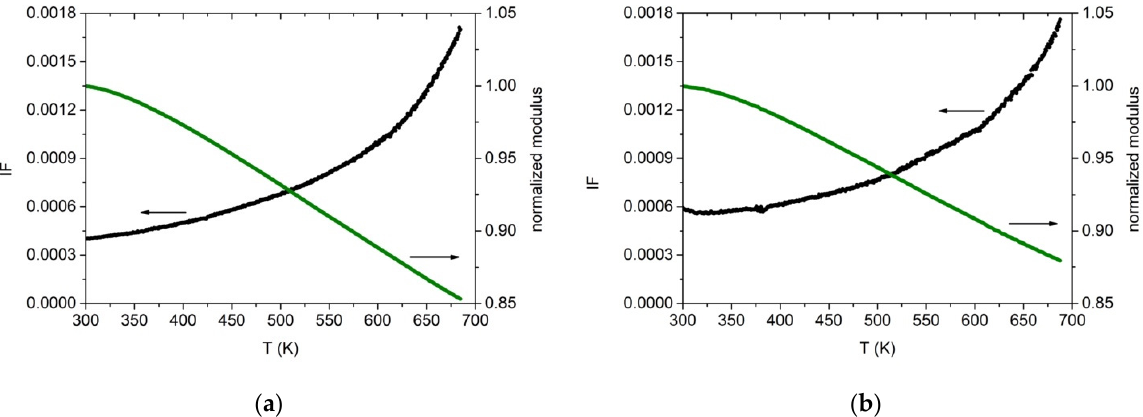
Figure 13. Internal friction (black) and dynamic elastic modulus (green) for cold-worked specimens with ( a ) Co 20 Cr 20 Ni 20 Fe 20 Mn 20 and ( b ) with Co 19 Cr 19 Ni 19 Fe 19 Mn 19 Zr 5 nominal composition. Heating rate 1.5 K/min. Resonance frequency at room temperature, 540 Hz ( a ) and 514 Hz ( b ). Modulus values are normalized to their value at 300 K.